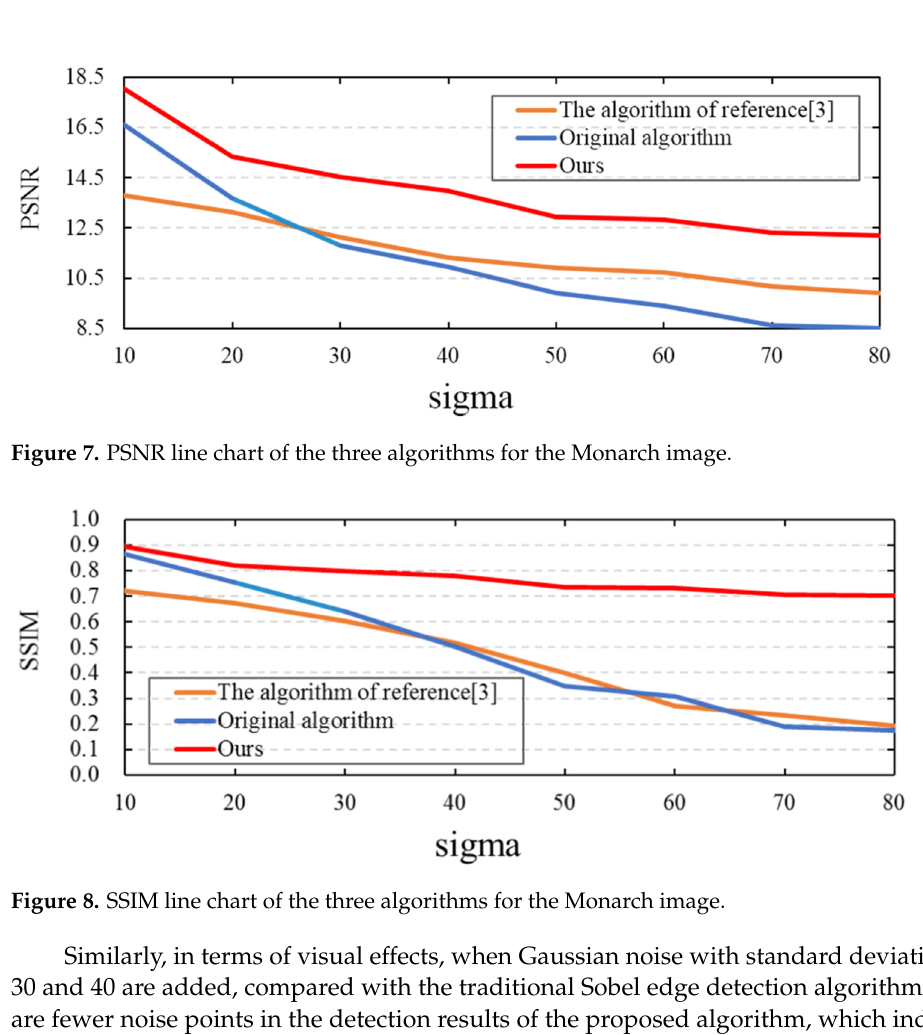
Figure 6. MSE line chart of the three algorithms for the Monarch image.